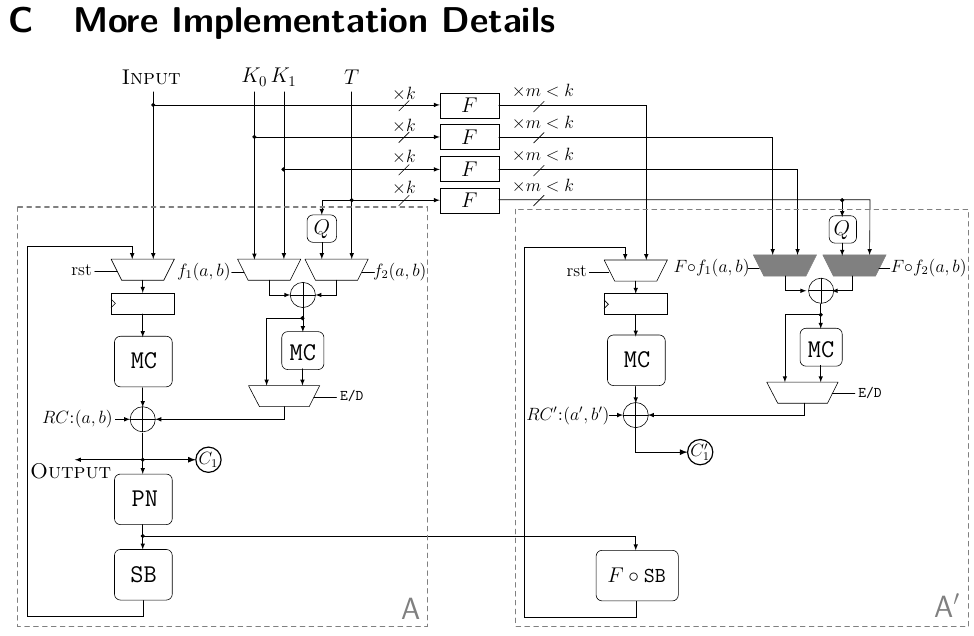
Figure 10: Round-based design architecture of CRAFT with fault detection, m < k (control unit not shown, checking PN output not required).